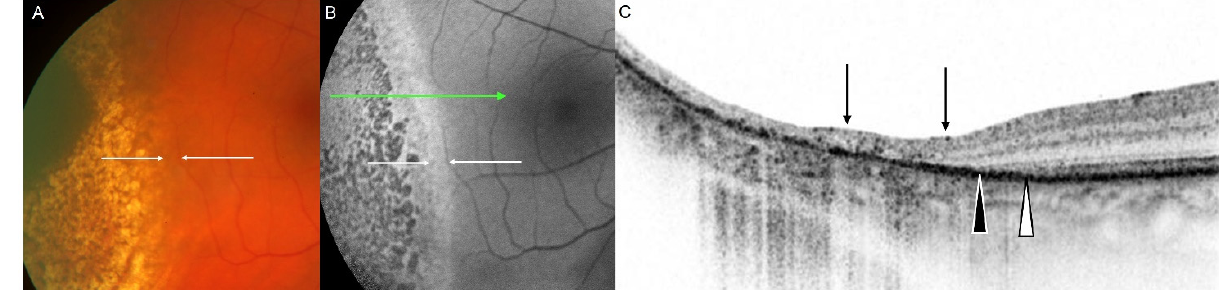
Figure 5. ( A ) Fundus photograph and ( B ) fundus autofluorescence image 6 months after ruthenium- 106 brachytherapy (CCB plaque, Bebig GmbH, Berlin, Germany; scleral dose 650 Gy) of a choroidal melanoma with 4 mm tumour height before therapy in a 58-year-old female patient. ( A ) Visible changes on the fundus photograph encompass a smaller area, ( B ) compared to alterations seen on the fundus autofluorescence image. ( C ) The corresponding OCT scan shows loss of the ellipsoid zone (white arrowhead) and loss of the external limiting membrane (black arrowhead) that appear overlying an intact retinal pigment epithelial cell layer, and even outside visible changes on the fundus photograph and the fundus autofluorescence image. The area of temporal retinal atrophy is accompanied by changes at the level of the retinal pigment epithelium (e.g., RPE migration, RPE clumping, RPE atrophy). The fundus photograph was taken using FF 450 plus (Carl Zeiss Meditec AG, Jena, Germany); fundus autofluorescence and OCT: SPECTRALIS HRA+OCT, Heidelberg Engineering, Heidelberg, Germany). Reproduced from Bindewald-Wittich et al. [91] with permission from S. Karger AG, Basel.